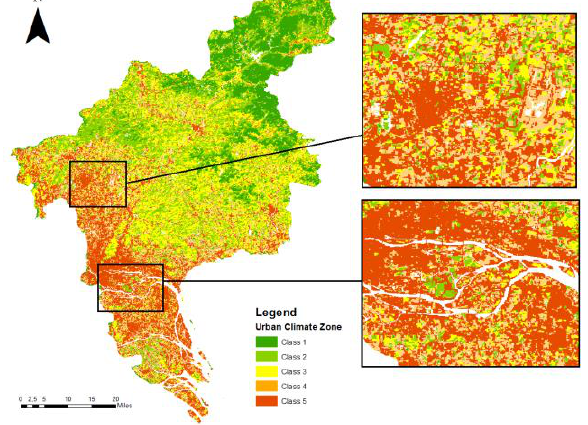
Figure 4. The result of LCZ in August of